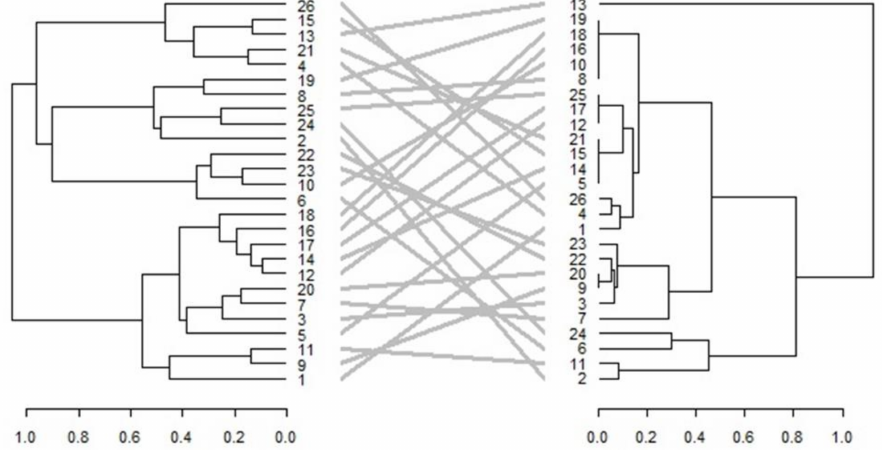
Figure 8. Tanglegram comparison of phenotypic and genotypic hierarchical clusters of 26 okra accessions based on 9 SSR markers and phenotypic data measured under non-stressed